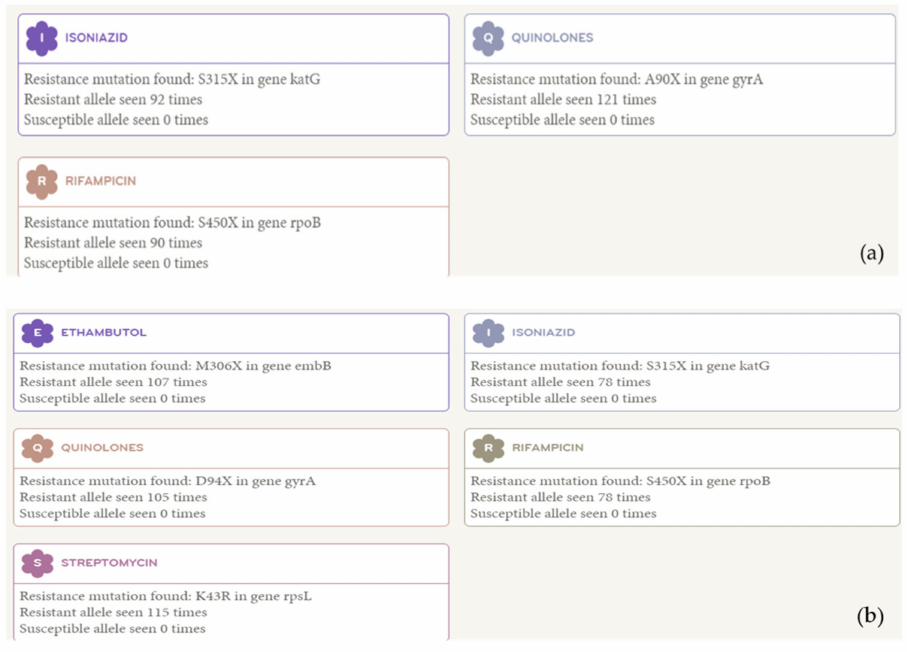
Figure 2. The gene mutation results of strains isolated from the patients. ( a ) The gene mutation results of the first, second, third, fourth, and fifth patients, ( b ) The gene mutation results of the sixth